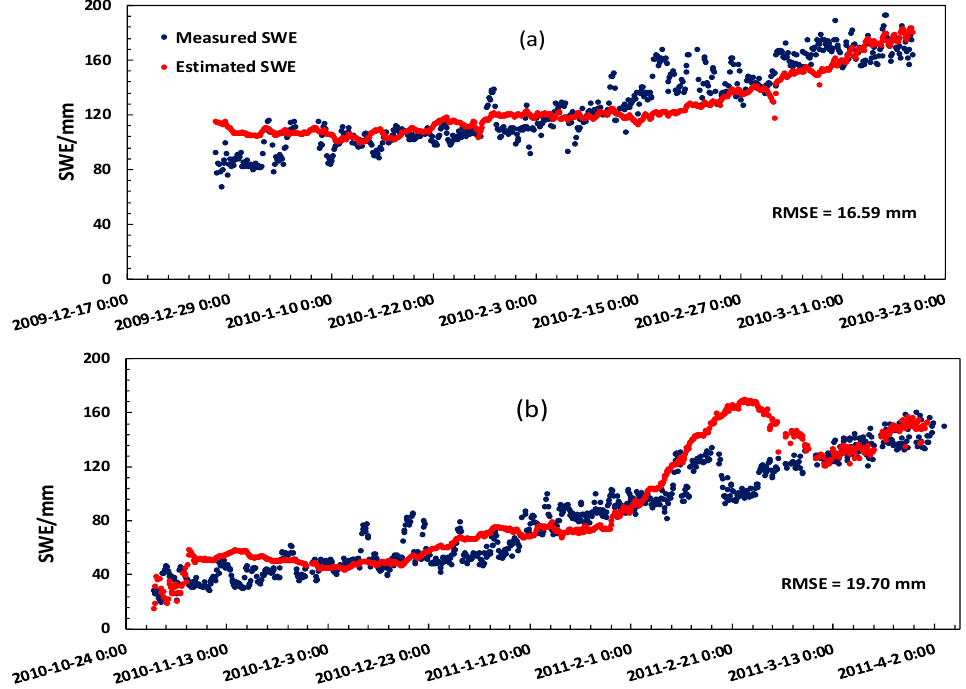
Figure 9. The time series of observed SWE ( black ) and estimated SWE ( red ) during: 27 December 2009–19 March 2010 ( a ); and 29 October 2010–4 April 2011 ( b ).